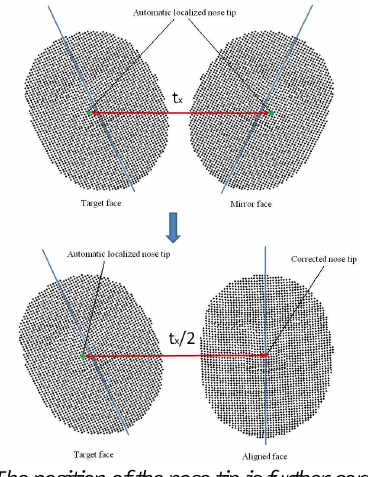
Fig. 12. The position of the nose tip is further corrected by , 0 , 0 ] as the transformation implementing [ t x 2